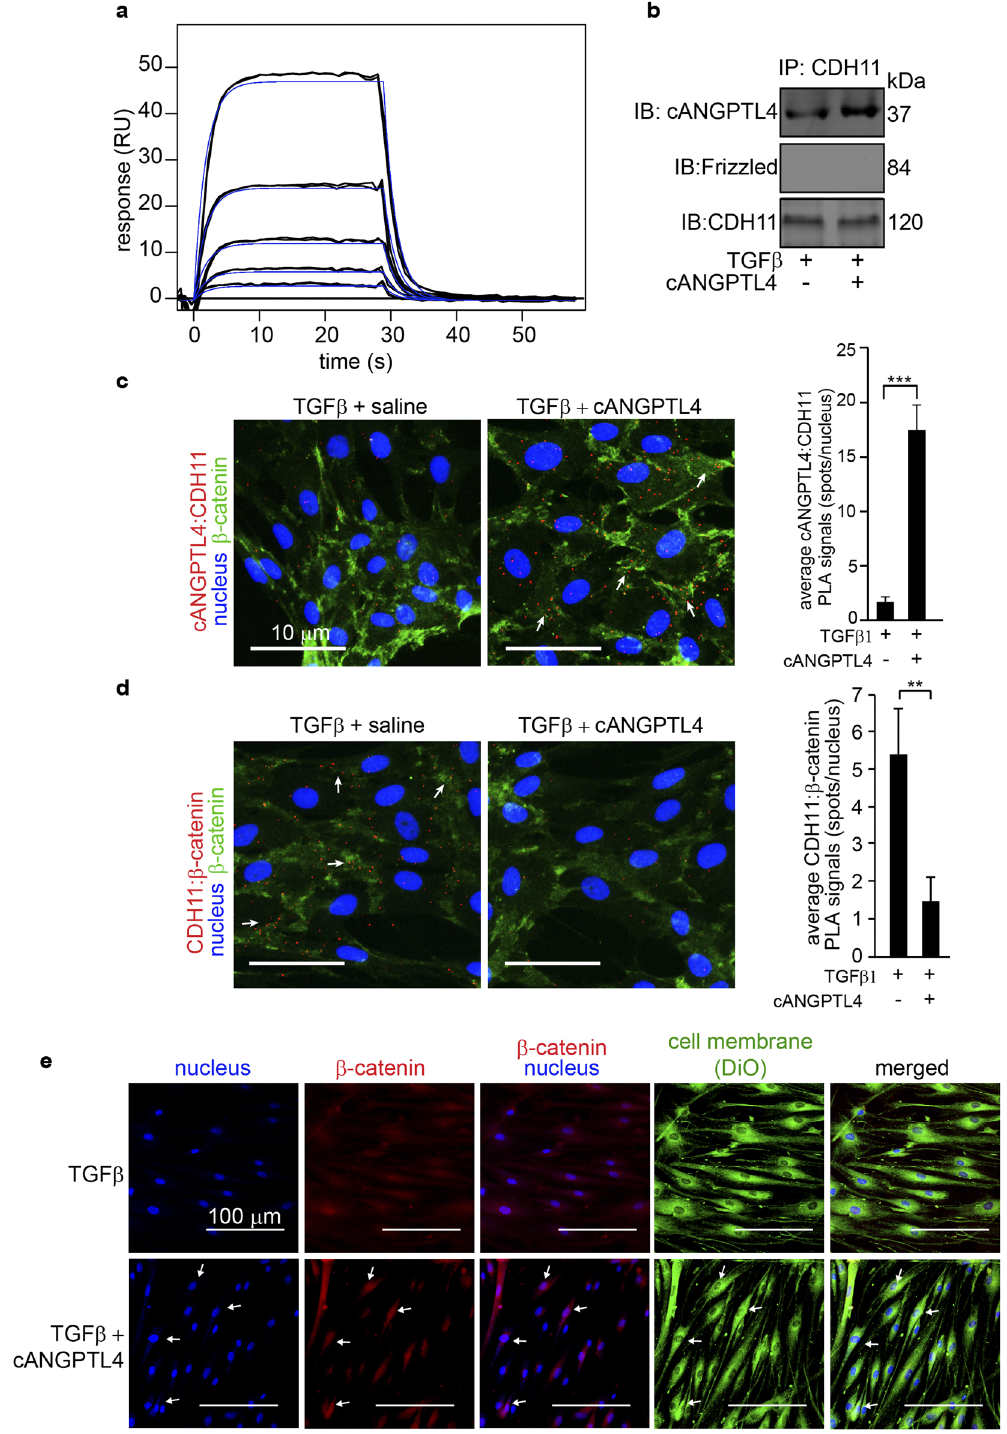
Figure 4. cANGPTL4 interacts with CDH11 to trigger the nuclear translocation of β -catenin in fibroblasts. ( a ) Representative sensorgram showing the interaction between recombinant cANGPTL4 and immobilized CDH11. The association and dissociation phases of the curves were analyzed using a single-site fit binding model (Langmuir 1:1 model). ( b ) Immunoprecipitation of CDH11 followed by immunodetection of indicated proteins from lysates of fibroblasts treated with TGF β in the absence or presence of cANGPTL4. Immunoprecipitated CDH11 from the same protein samples was used as loading and transfer controls. Cropped images are representative of immunoblots from n = 5 independent experiments; full-length immunoblots scanned using the Li-Cor Odyssey ® CLx system can be found in Supplementary Fig. S4h–i. ( c,d ) Detection of cANGPTL4:CDH11 ( c ) and CDH11: β -catenin ( d ) complexes in fibroblasts treated with 10 ng/mL of TGF β 1 (control) or TGF β 1 plus 12 µ g/mL of cANGPTL4 by proximity ligation assay (PLA).